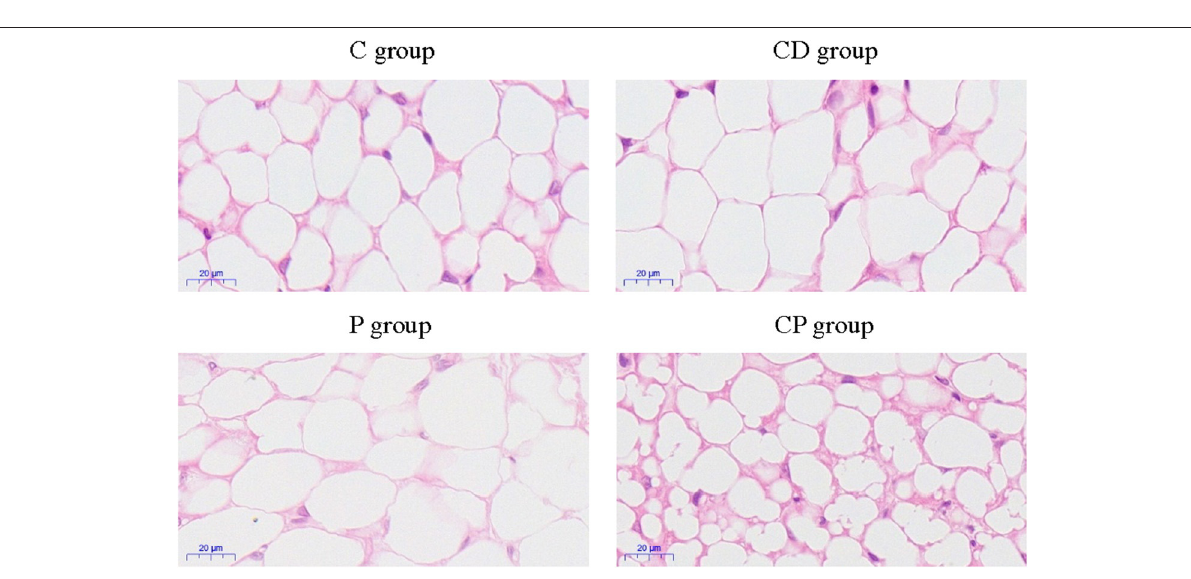
FIGURE 3 | The observation of subcutaneous adipose tissues by H&E staining of four treatment groups ( ×